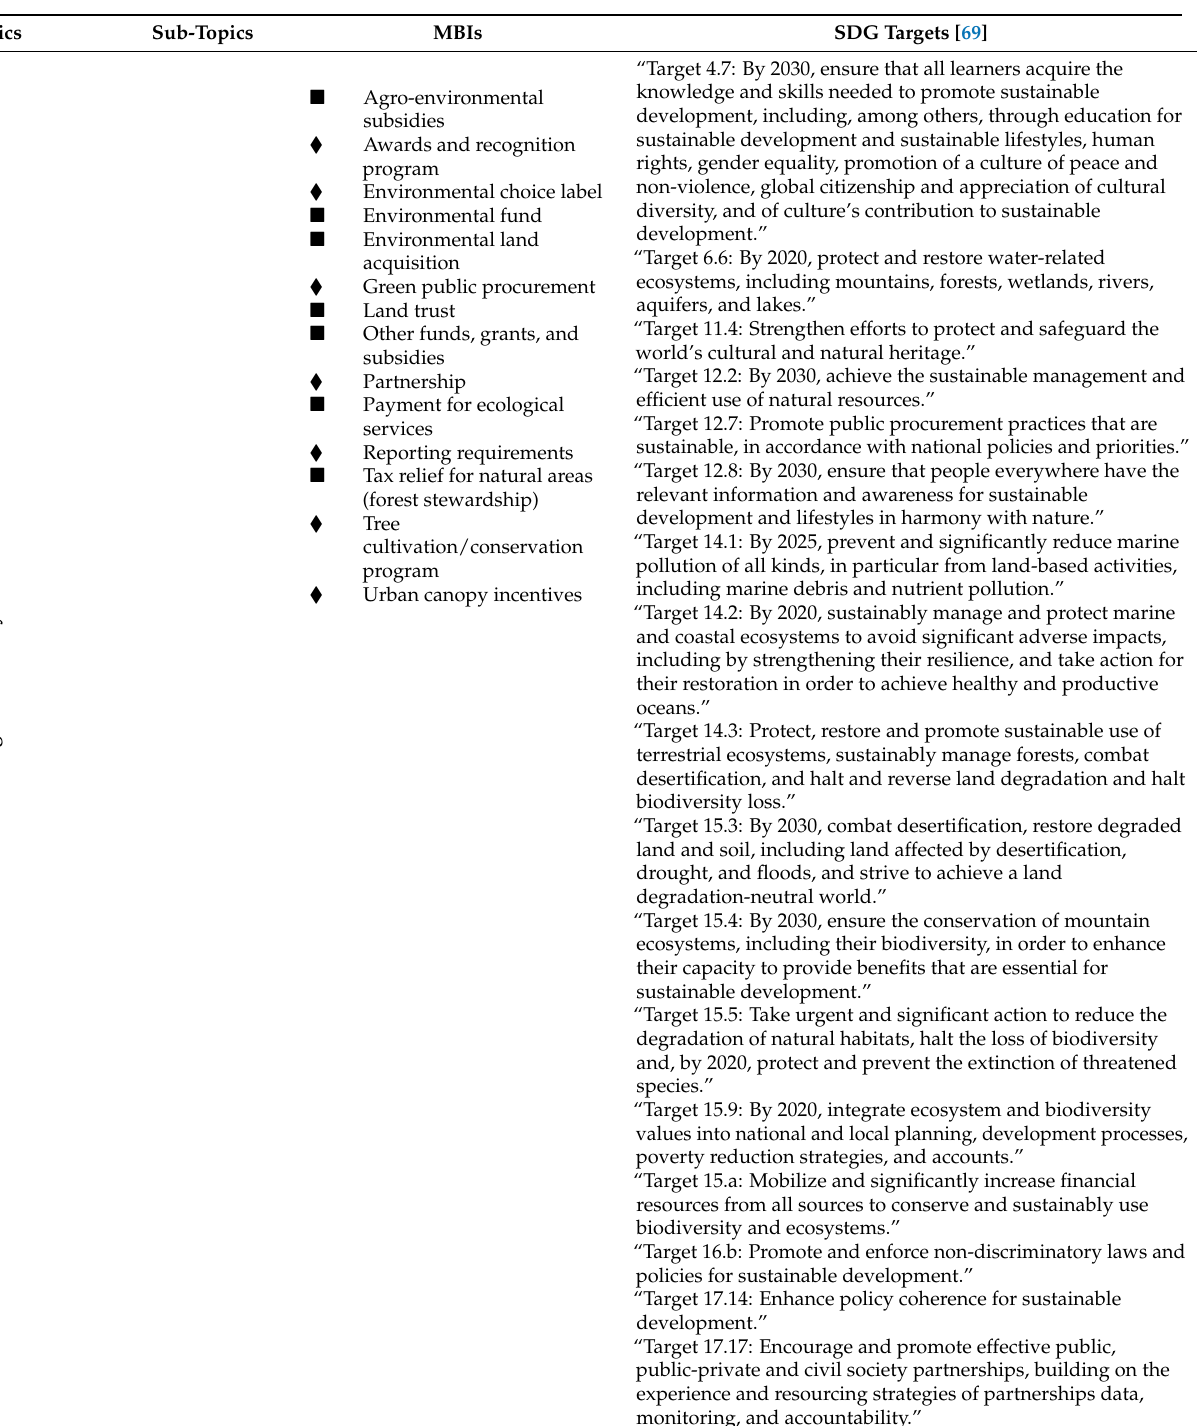
Table 10. Categorization of MBIs for Ecological Diversity and Related SDG